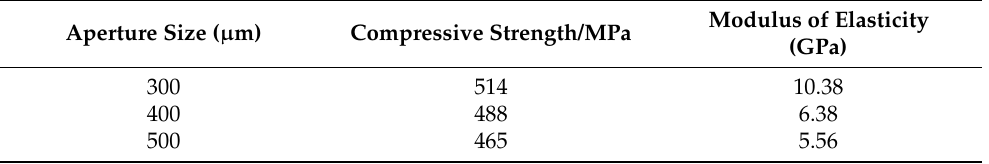
Table 3. Compressive strength and elastic modulus of different apertures.